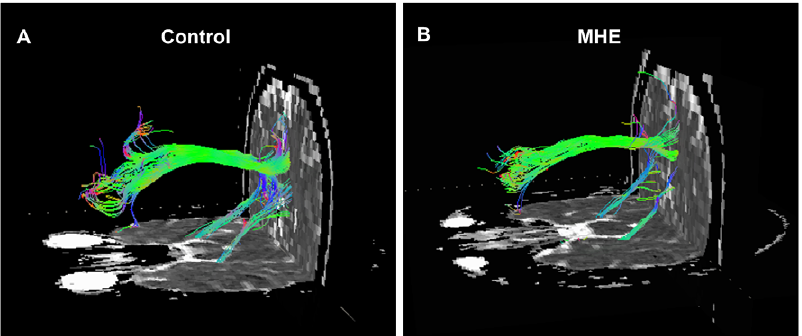
Figure 2. Example of DTI fiber tractography on one healthy control and one MHE patient. Only three fiber bundles connecting the PCC/ PCUN and MPFC, bilateral PHGs were detected in all the subjects. The color-coding of the obtained fibers is based on the standard RGB (Red, Green, Blue) code applied to the vector at every segment of each fiber. Red indicates the medio-lateral plane. Green indicates the dorsoventral orientation. Blue indicates the rostro-caudal direction. DTI=diffusion tensor imaging; MHE=minimal hepatic encephalopathy; PCC/PCUN=posterior cingulate cortex/precuneus; MPFC=medial prefrontal cortex; PHG=parahippocampal gyrus.